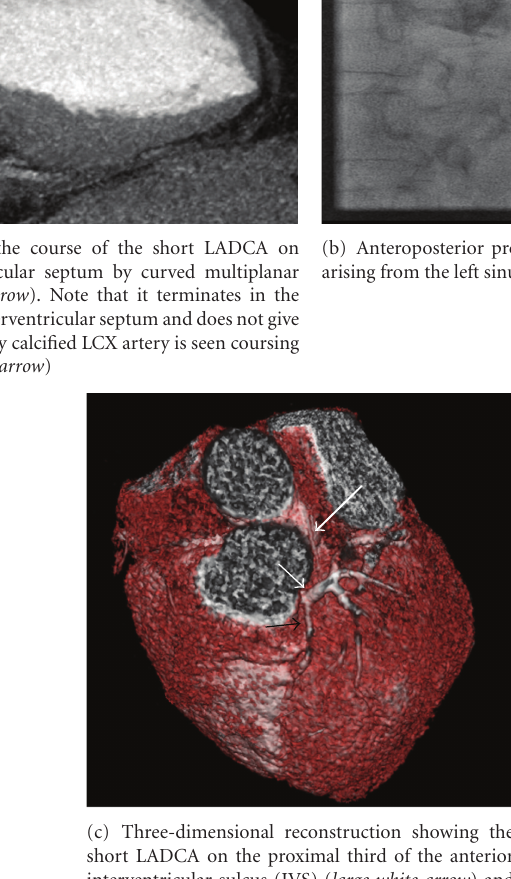
Routine coronary angiography may fail to